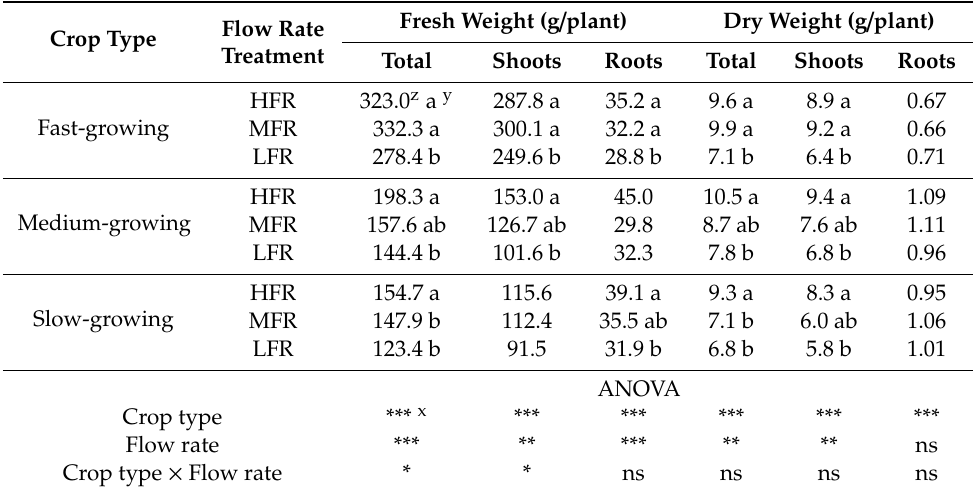
Table 5. Fresh and dry weight of fast-growing, medium-growing, and slow-growing crops grown in aquaponics with high (HFR, 3.3 m / day), medium (MFR, 2.2 m / day), and low (LFR, 1.1 m / day) flow rate.